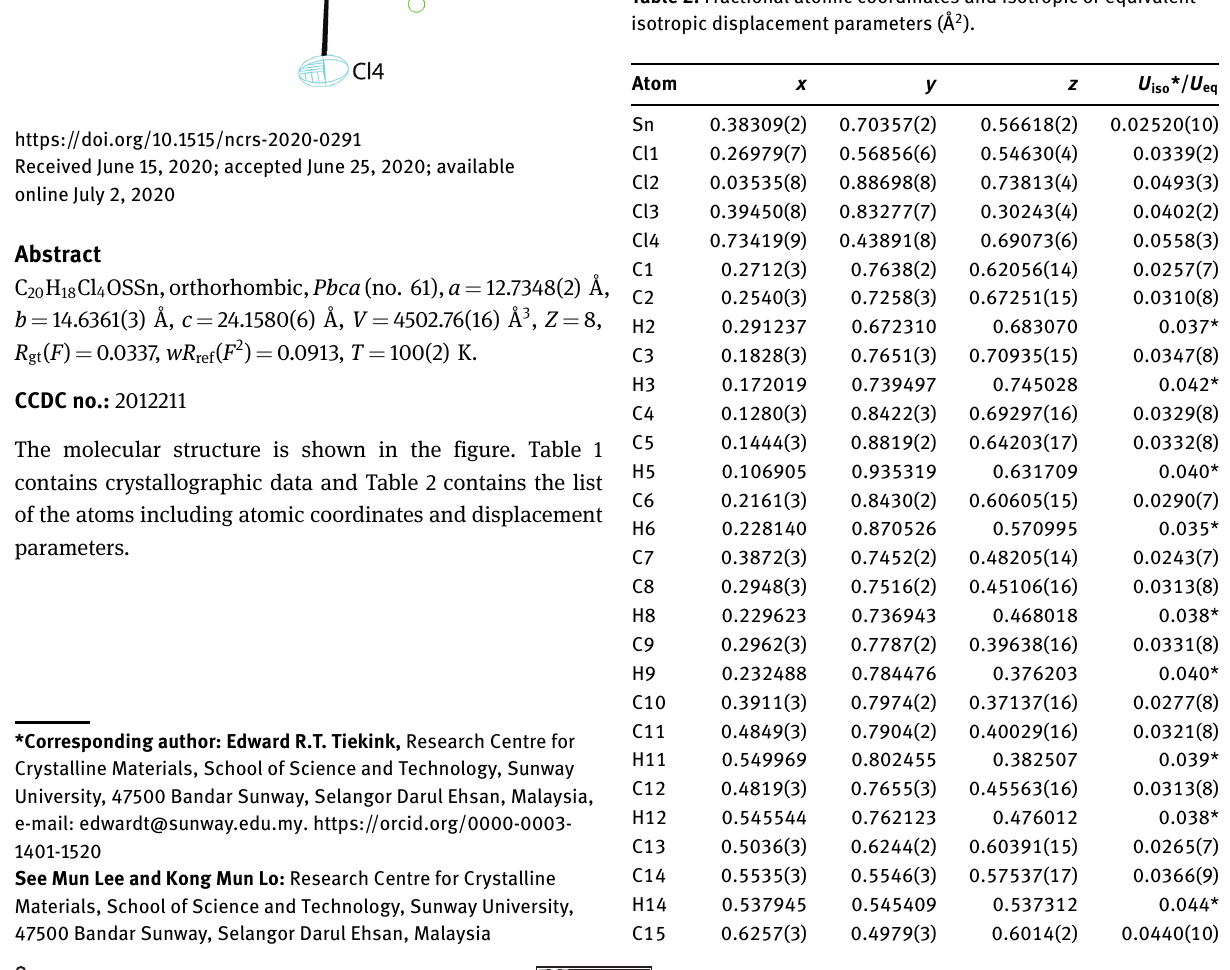
Table 2: Fractional atomic coordinates and isotropic or equivalent isotropic displacement parameters (Å 2